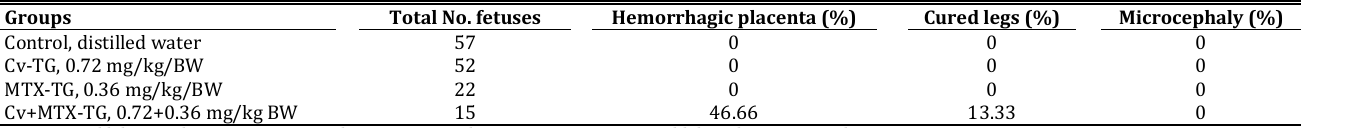
Table 2 . Number and percentages anomalies of alive fetuses of euthanized treated pregnant rat groups with carvedilol, methotrexate alone and combined at one day before parturition Groups